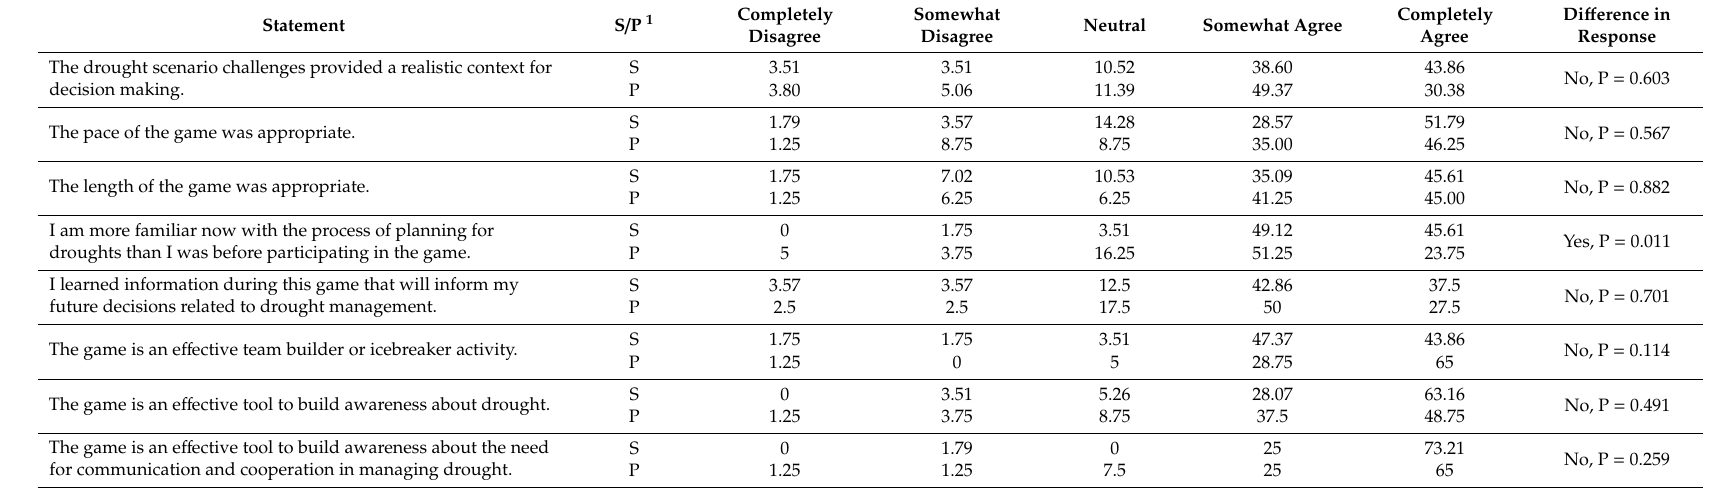
Table 1. Responses of the participants (in percent of received responses) to a question about their level of agreement with various statements about the game. Di ff erence in responses between students and professionals was measured using Person’s Chi Squared and is presented using the associated probability